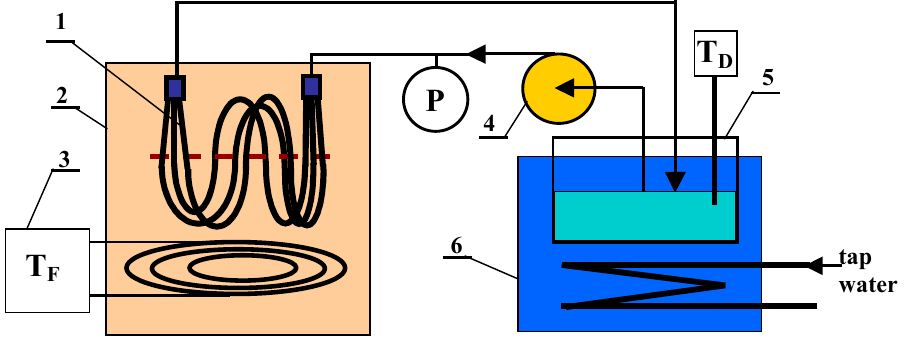
Figure 3. MD process experimental set-up. 1—submerged MD module, 2—feed tank, 3—feed temperature regulator with electric heater, 4—peristaltic pump, 5—distillate tank, 6—cooling bath, T—thermometer, P—pressure gauge.